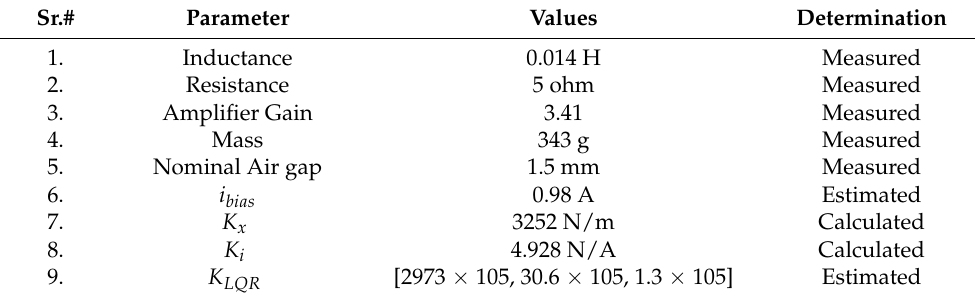
Table 1. AMB system parameters.